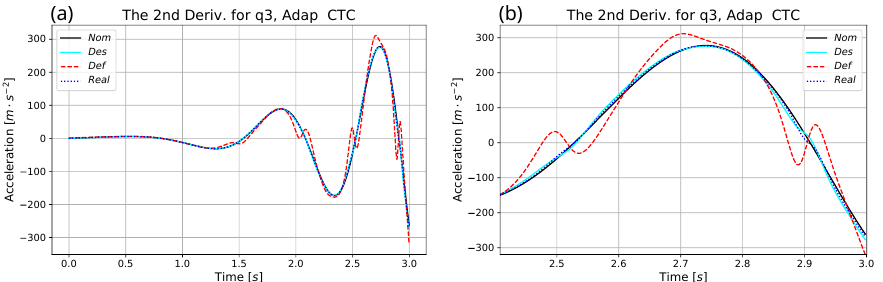
Figure 19. Second time derivatives for q 3 ( a ) and the zoomed-in excerpts ( b ) for the adaptive CTC controller using the identified parameters.